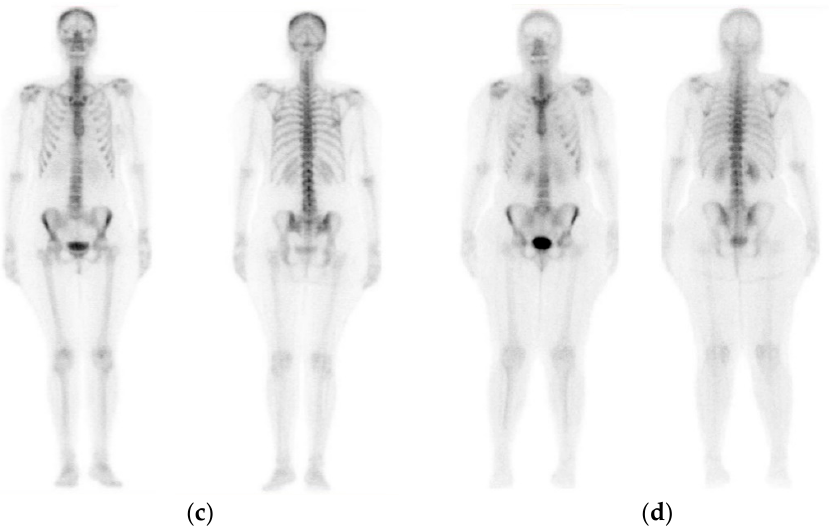
Figure 1. Image breast cancer bone metastasis samples in the dataset (Label: ( a , b ) malignant and ( c , d ) benign).